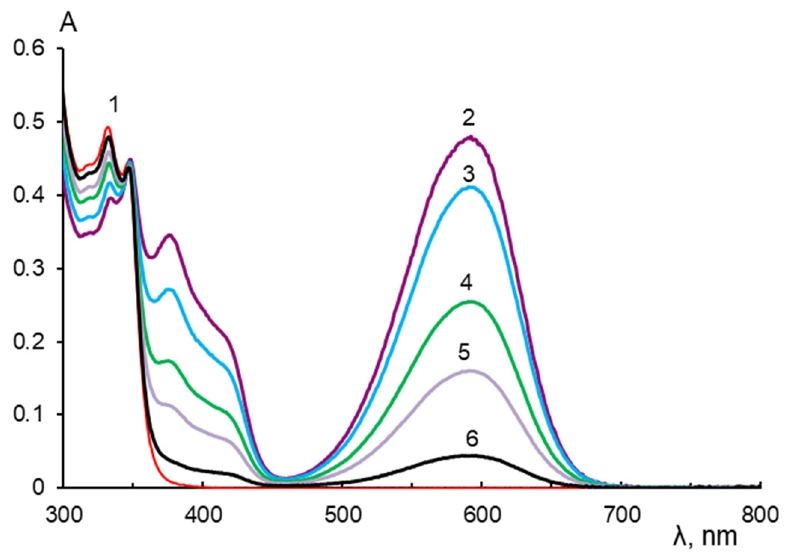
Figure 1. Absorption spectra of compound 2 in the mixed solvent solution before (1), after UV irradiation (2) and after relaxation in the dark (3–6).